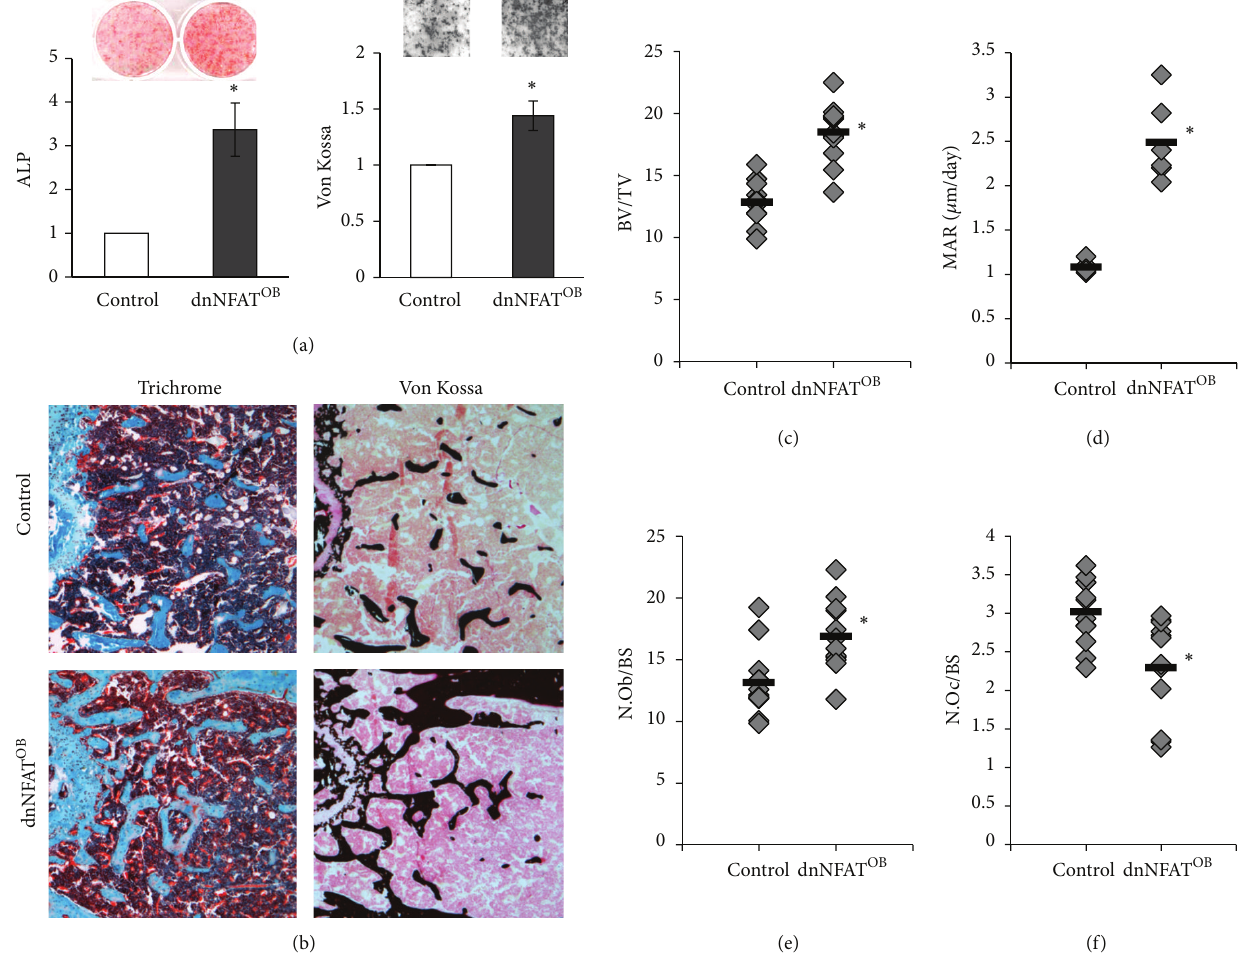
Figure 2: Inhibition of NFAT activation in osteoblasts increases osteoblast differentiation and bone formation. (a) Primary osteoblasts were harvested from the calvariae of control and dnNFAT OB mice and cultured for 7 (alkaline phosphatase, ALP) or 21 (von Kossa) days in the presence of 𝛽 -glycerophosphate and ascorbic acid-2-phosphate to induce osteoblast differentiation. Cells were stained for ALP activity ( red ) or for mineralization by von Kossa ( black ). Images are representative of three independent experiments, each repeated in duplicate. (b) Femora from 12-week-old control and dnNFAT OB mice were stained with Goldner’s Trichrome ( blue ) and von Kossa ( black ) staining to show mineralized bone. Magnification, 200x. (c–f) Histomorphometrical indices were measured from 12-week-old control ( 𝑛 = 6 ) and dnNFAT OB ( 𝑛 = 6 ) mice and show (c) bone volume/tissue volume (BV/TV), (d) mineral apposition rate (MAR) ( 𝜇 m/day), (e) osteoblast number/bone surface (N.Ob/BS), and (f) osteoclast number/bone surface (N.Oc/BS). Values represent individual mouse measurements with the mean indicated by the black bar; ∗ 𝑃 ≤ 0.01 when compared to control